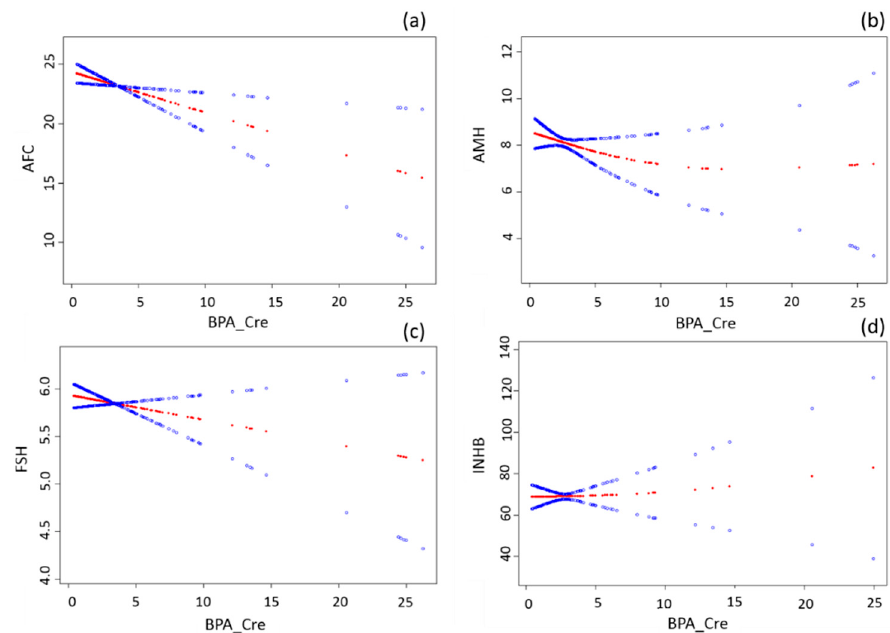
Figure 1. The relationships between BPA and antral follicle count, antimullerian hormone, inhibin B, and follicle stimulating hormone levels. The x-axis refers to urinary BPA level corrected by creatinine concentration (BPA_Cre). The y-axis refers to AFC ( a ); AMH ( b ); FSH ( c ); and INHB ( d ) levels. The red line is fitted by generalized additive model showing the relationship between x and y axes. The two blue lines refer to 95% confidence intervals. All models were adjusted for age, BMI, income.